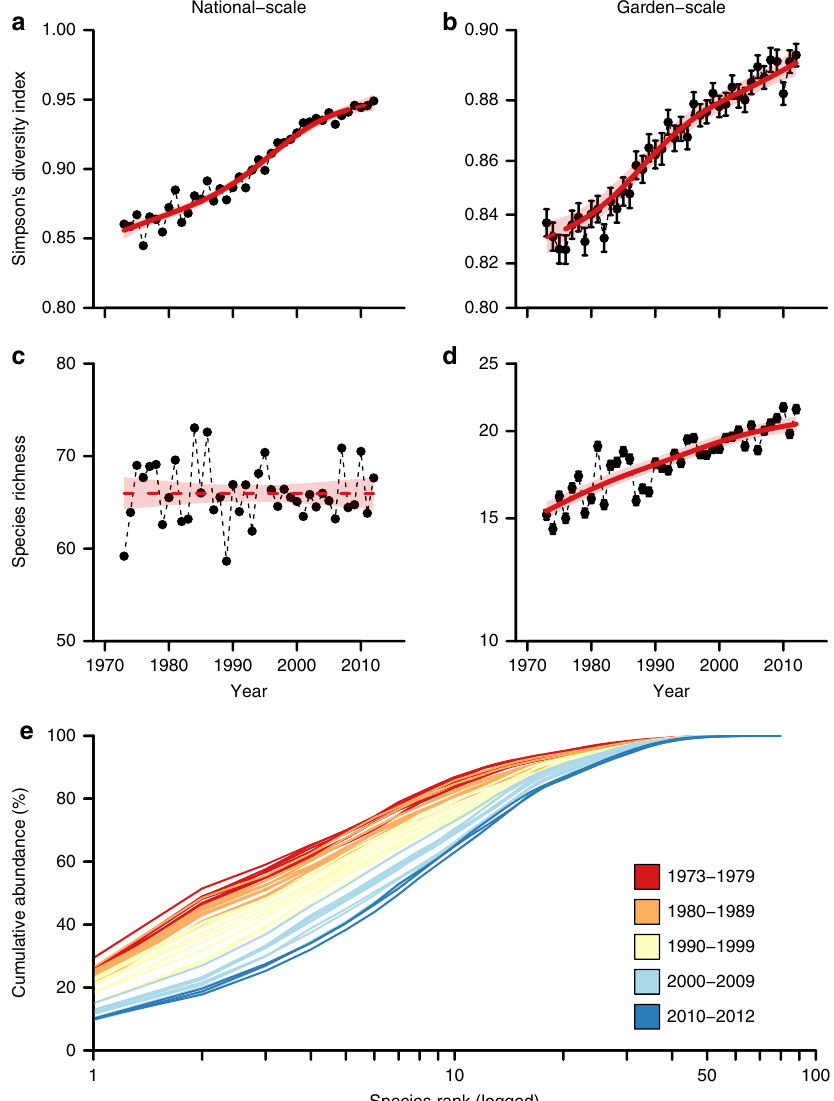
Fig. 2 Long-term changes in the diversity of birds using garden bird feeders. a , b trends in Simpson ’ s diversity at a national-scale ( a ), and a garden-scale ( b ). c , d trends in species richness at a national-scale ( c ), and a garden-scale ( d ). For a – d , model- fi tted trends are shown with 95% con fi dence limits (pale shading), periods of signi fi cant change are shown with a solid line and non-signi fi cant periods with a dashed line; dots show annual values ( a , c ) or annual means with error bars depicting s.e.m. ( b , d ). e k -dominance curves for each year in the time-series ( n = 40) coloured by